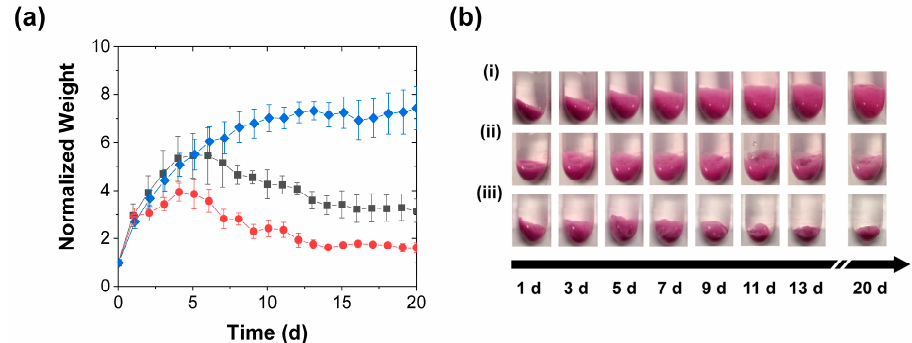
Figure 5. Swelling of coacervates during RhB release into deionized water achieved with ( ■ ) daily perforation by two needle jabs, ( • ) daily compression, and ( (cid:7) ) without mechanical stimulation and characterized by ( a ) gravimetric analysis of the evolutions in normalized weights (mean ± SD) and ( b ) digital photography (i) without mechanical stimulation, (ii) with periodic perforation, and (iii) periodic compression. All coacervate weights are normalized to their initial values at the start of the release experiment. The lines are guides to the eye.